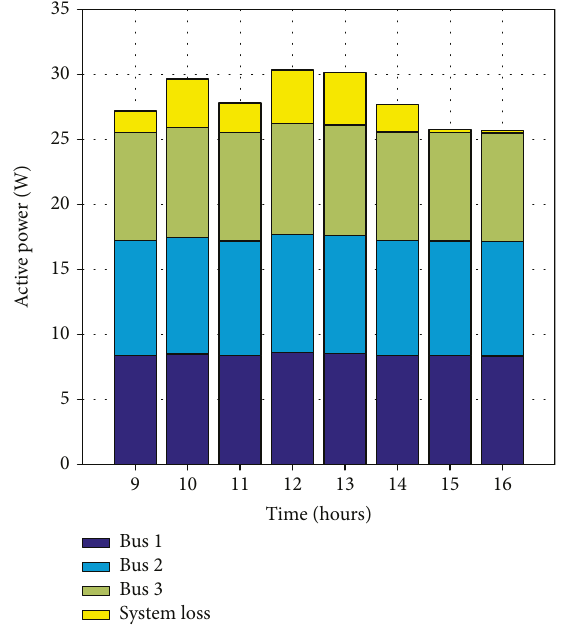
Figure 13: Distributed power in the simulation model of multiple-source con fi guration.